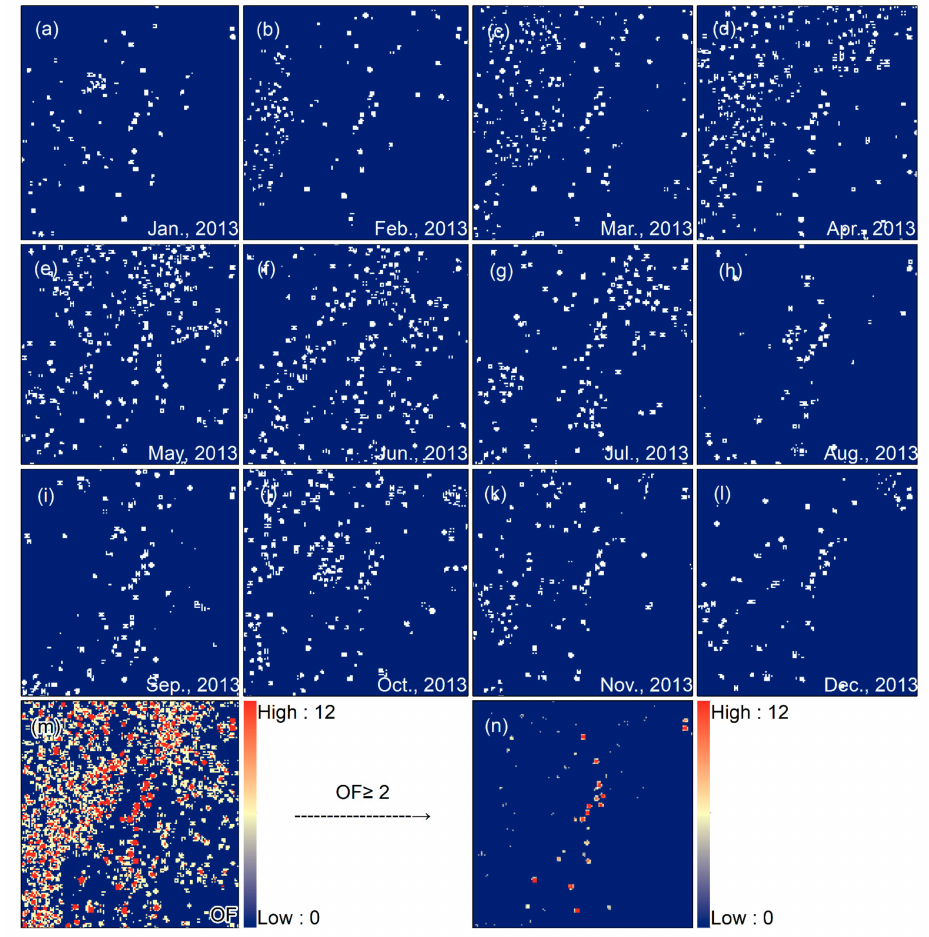
Figure 5. Target OF statistics: ( a –l) are the binarized segmentation results of time-series images in one year, with a threshold t = 0.5; ( m ) is the OF statistics; ( n ) is the purified result, the threshold f = 2. The parameters used in the above process refer to empirical values, which are obtained through estimation and trial and error, and remain unchanged for all NTL images